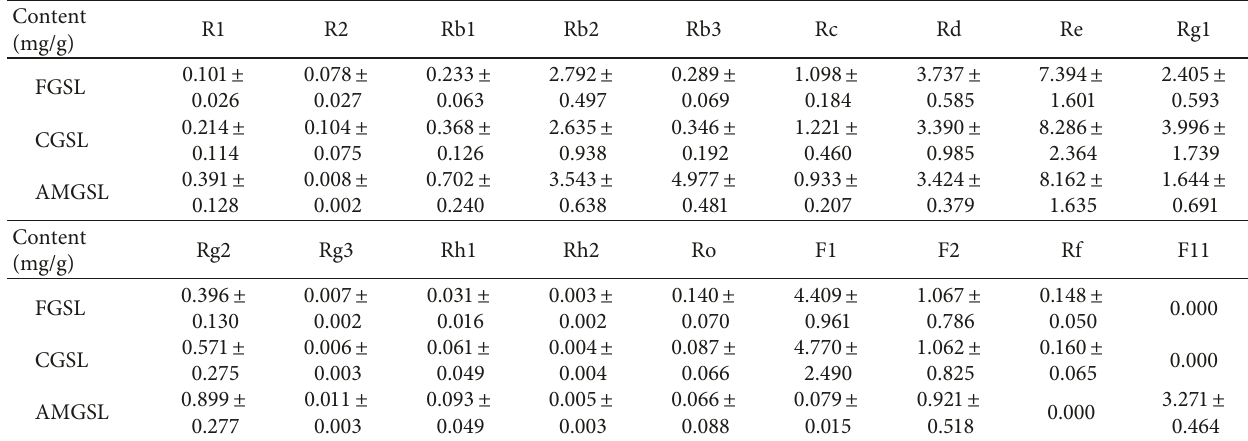
Table 8: Contents of the eighteen ginsenosides in ginseng